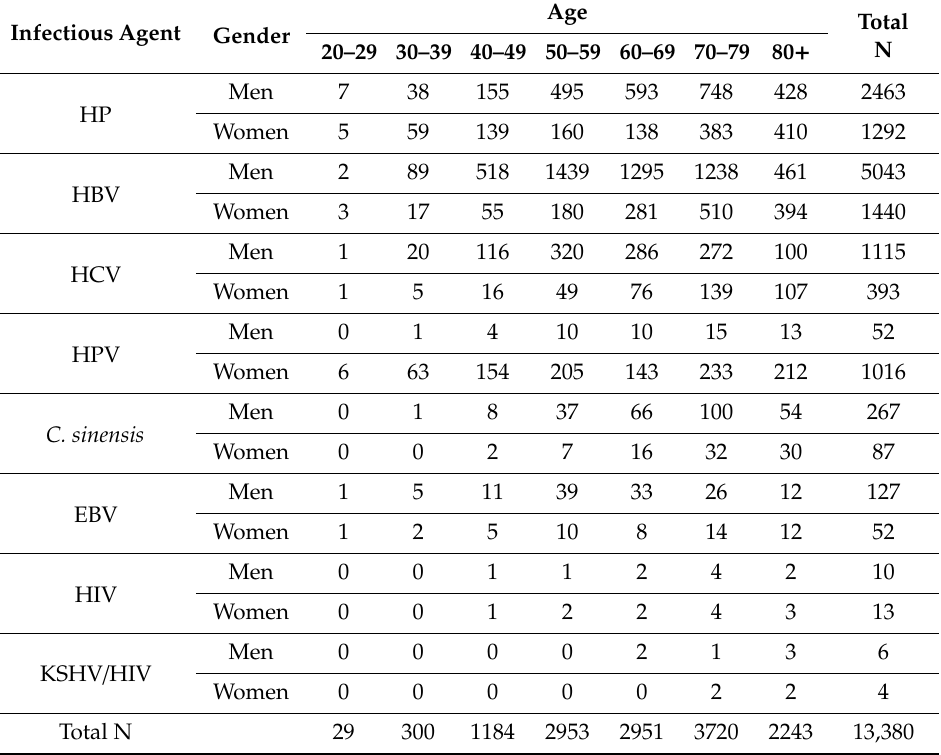
Table 2. The estimated number of deaths with infection-related cancers according to infectious agent in 2014, South